Question: According to the figure, is the described quantity increasing or decreasing?
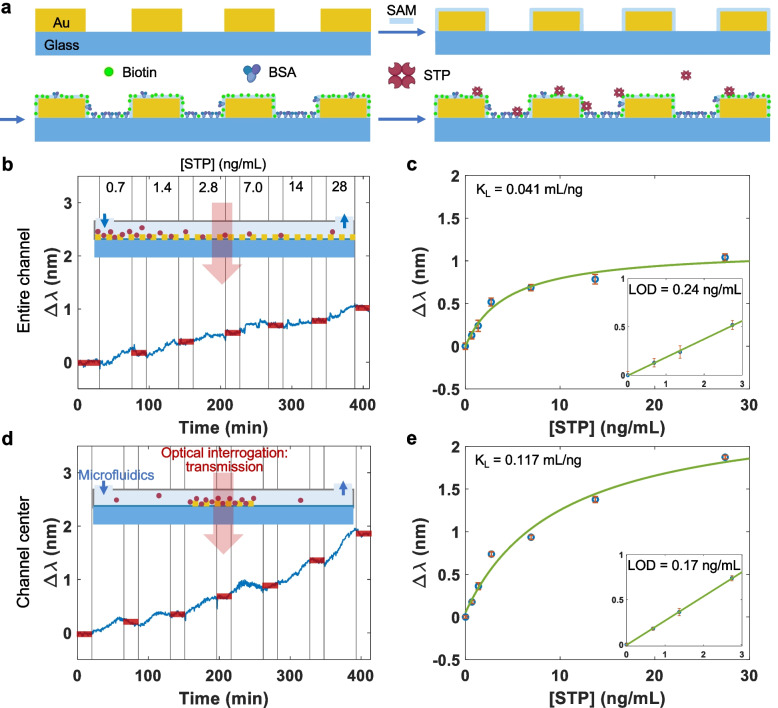
Answer: increasing